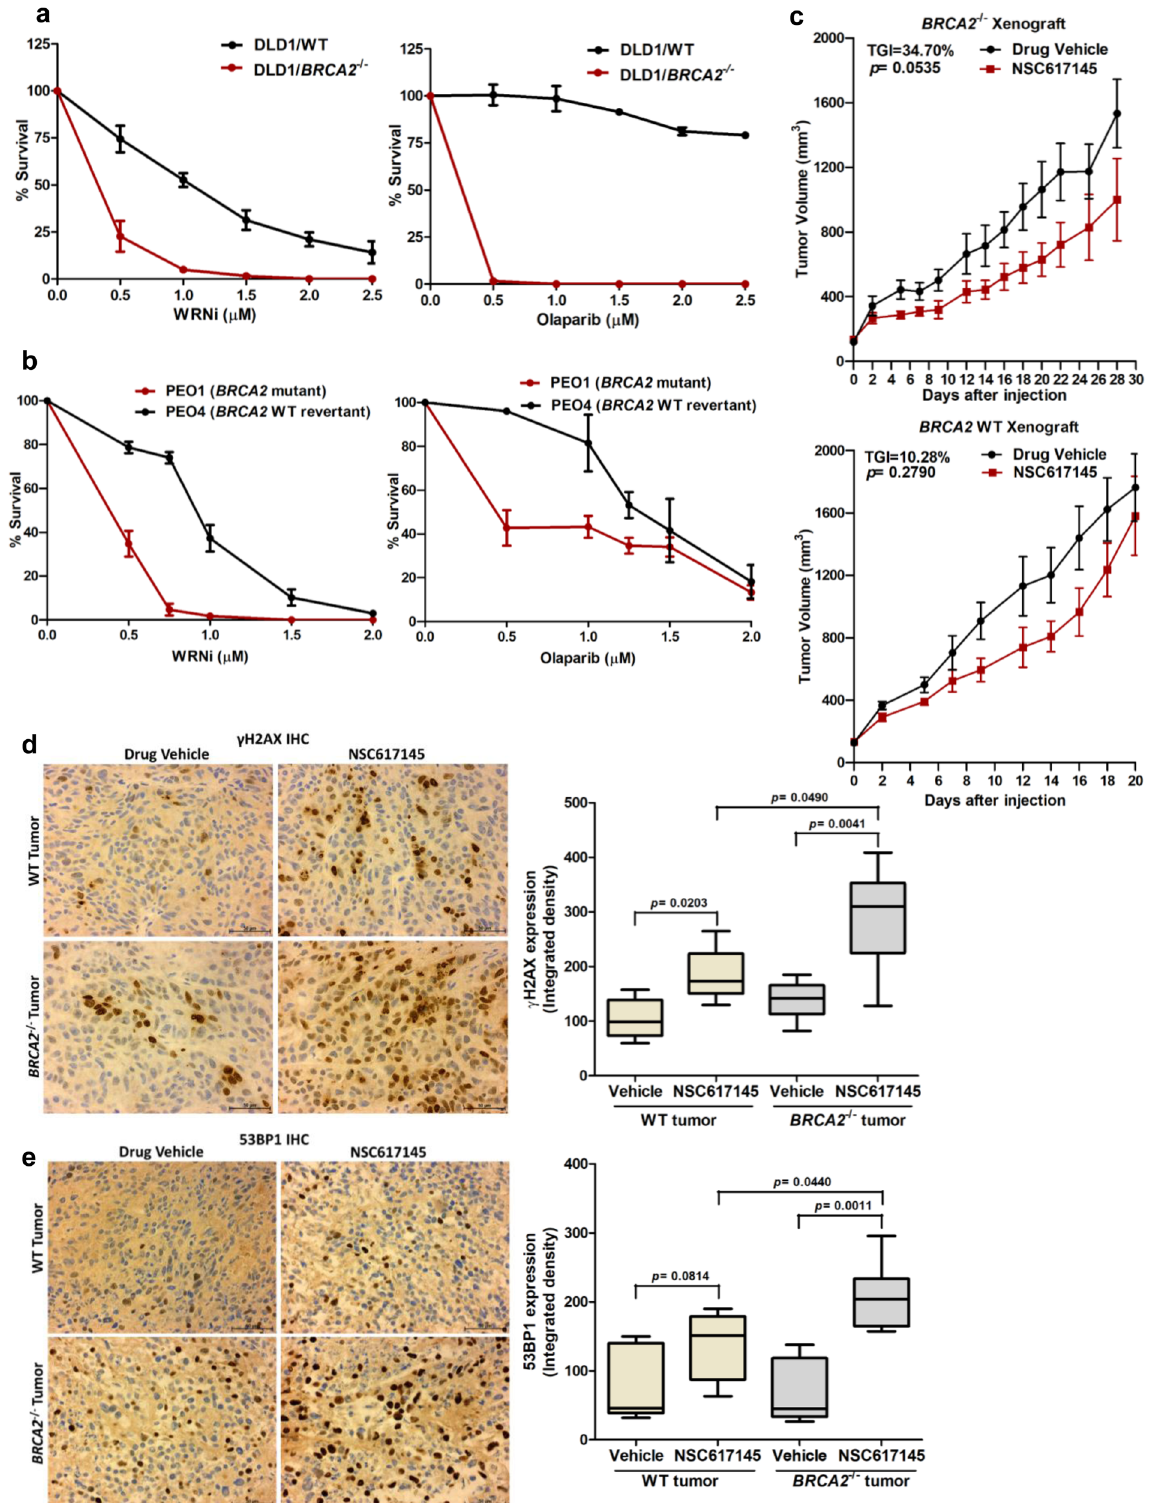
exonuclease activity suppresses nascent strand DNA